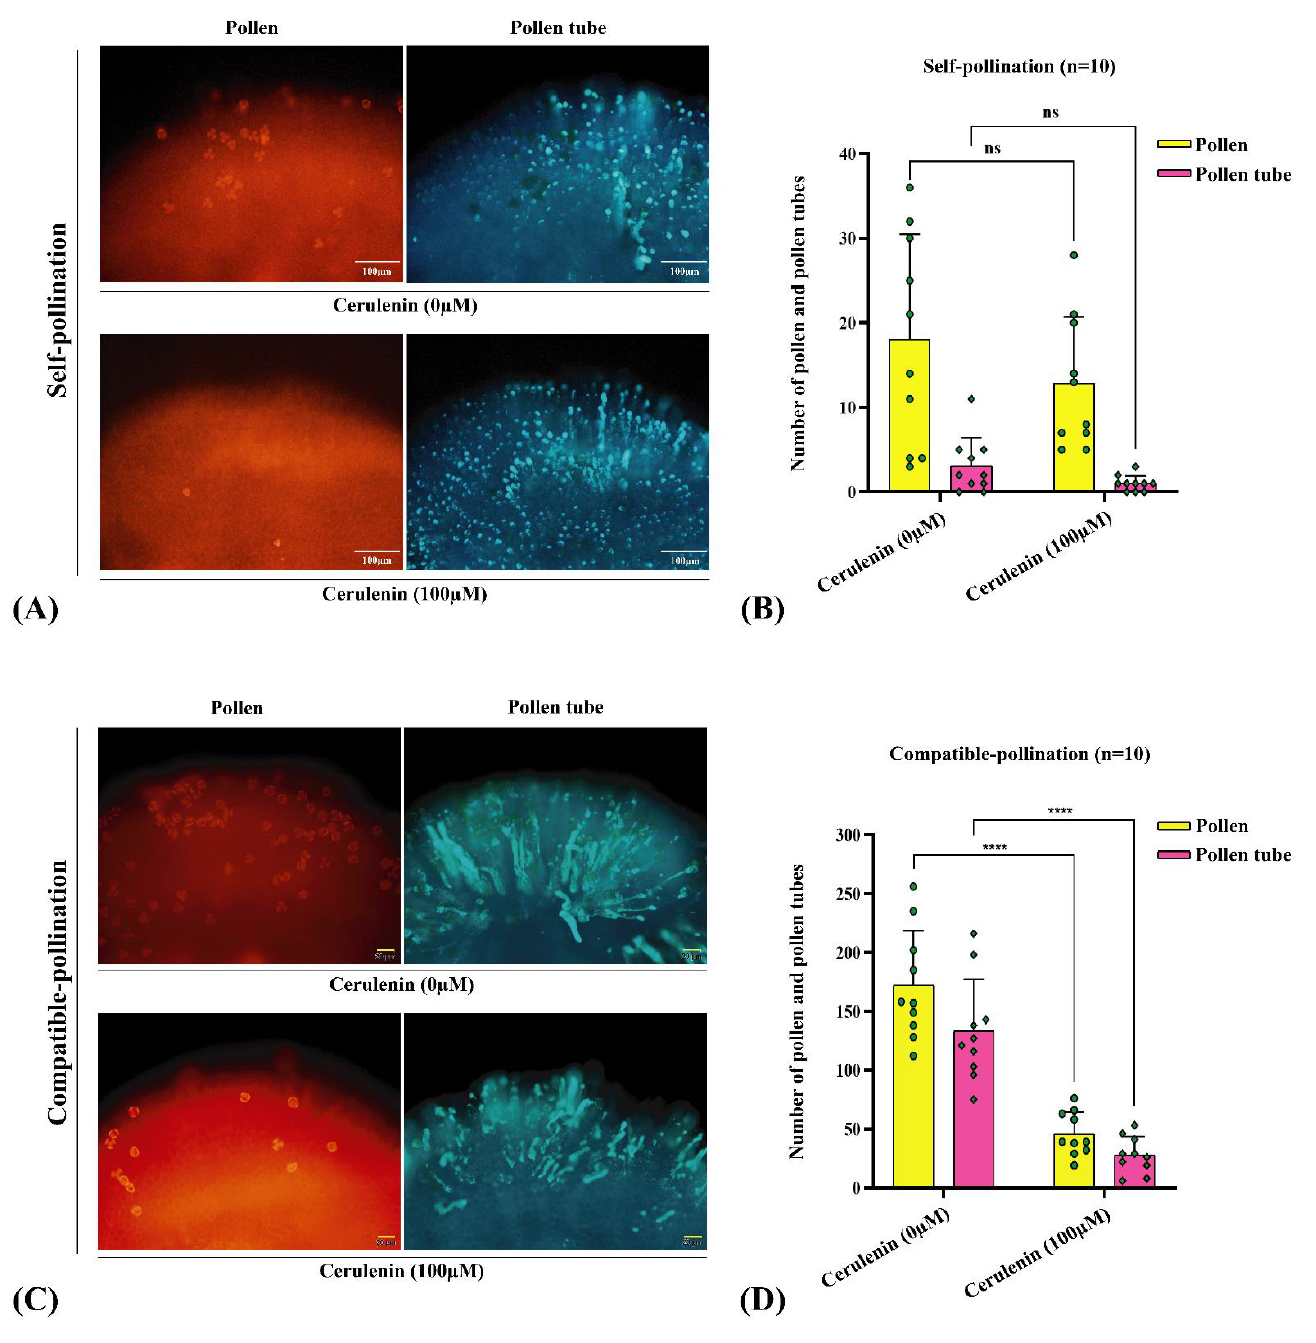
Figure 8. Effects of the fatty acid synthase (FASN) inhibitor on self-pollination and compatible pollination. ( A ) Fluorescence images of self-pollination after stigma were treated with cerulenin (100 µM). ( B ) Pollen and pollen tube number statistics of self-pollination after stigma were treated with cerulenin (100 µM). ( C ) Fluorescence images of compatible pollination after stigma were treated with cerulenin (100 µM). ( D ) Pollen and pollen tube number statistics of compatible pollination after stigma were treated with cerulenin (100 µM). Asterisks indicate significant difference (**** p < 0.0001 by Student’s t -test), ns indicate no significant difference. Error bars represent the standard error of the mean (n = 10). Scale bars = 50/100 µ